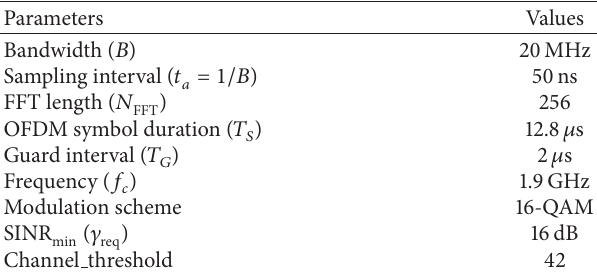
Table 1: OFDM system